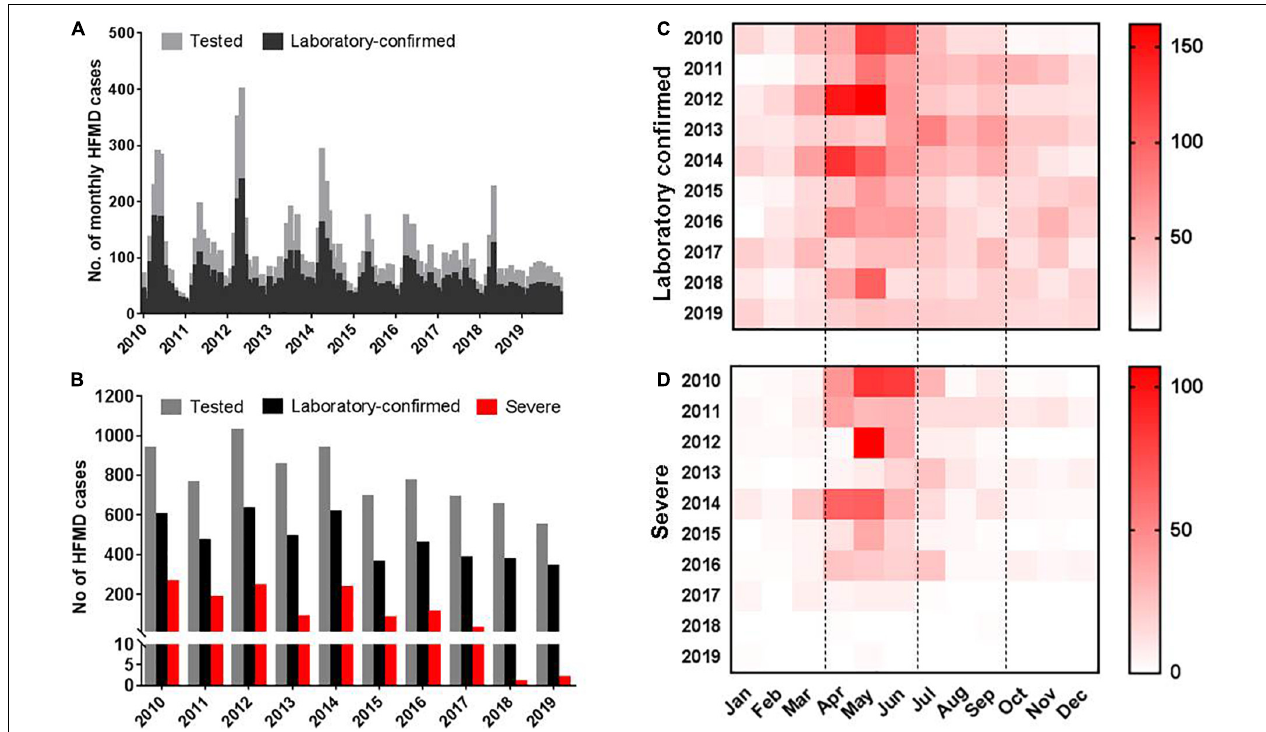
FIGURE 3 | Distribution of enterovirus-associated HFMD cases in Nanchang, China from 2010 to 2019. (A) Monthly distribution of tested and laboratory confirmed HFMD cases. (B) Yearly distribution of tested, laboratory confirmed and severe HFMD cases. (C) Monthly heatmap of laboratory confirmed cases. (D) Monthly heatmap of severe HFMD